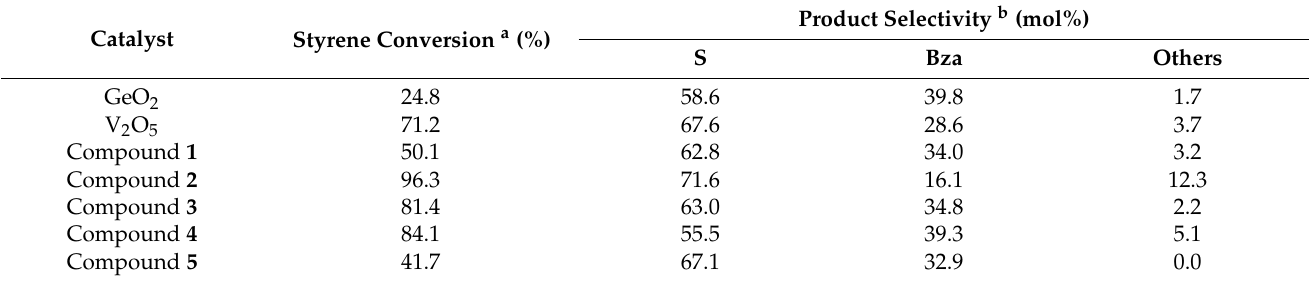
Table 2. Catalytic activity and product distribution.